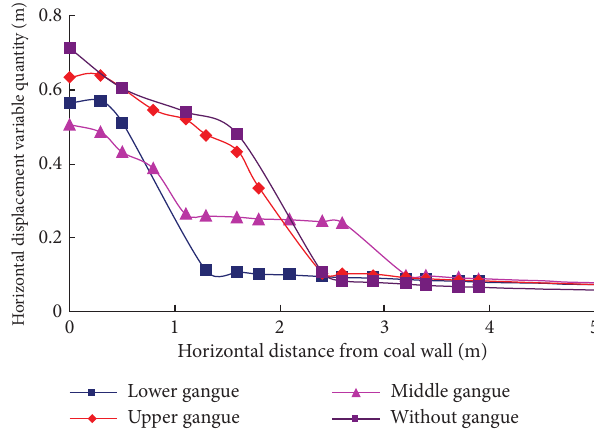
Figure 6: Horizontal displacement curve of coal seam. Figure 7: Variation curves of vertical stress outside coal seam top